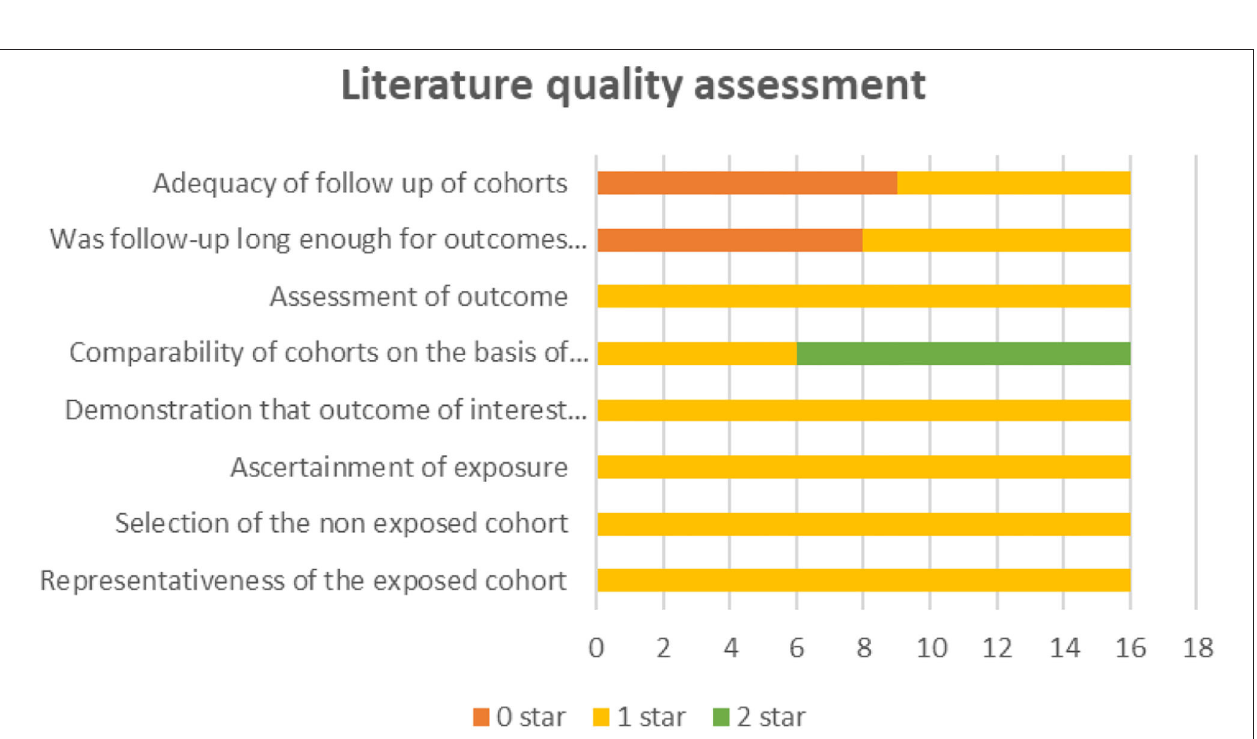
Frontiers in Surgery |